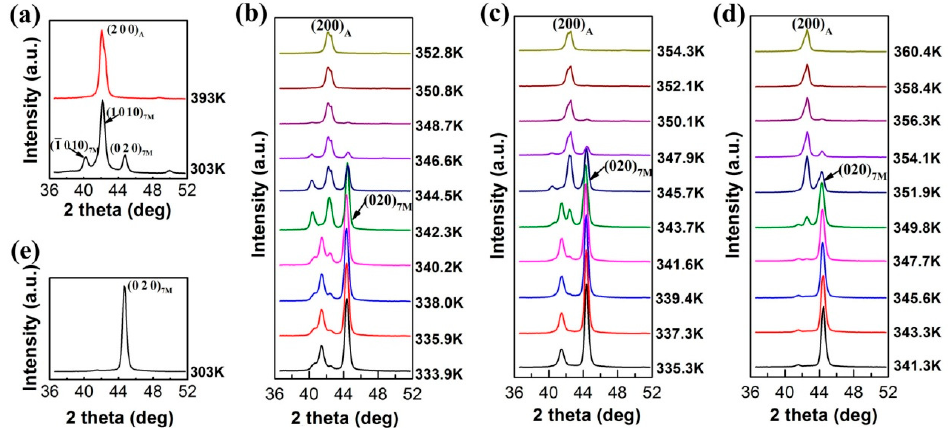
Figure 3. ( a ) Neutron diffraction pattern measured at ~393 K and ~303 K with no external load; ( b – d ) neutron diffraction patterns measured during cooling under the compressive load of − 10 MPa (Cycle 1), − 25 MPa (Cycle 2) and − 50 MPa (Cycle 3); and ( e ) neutron diffraction pattern measured at ~303